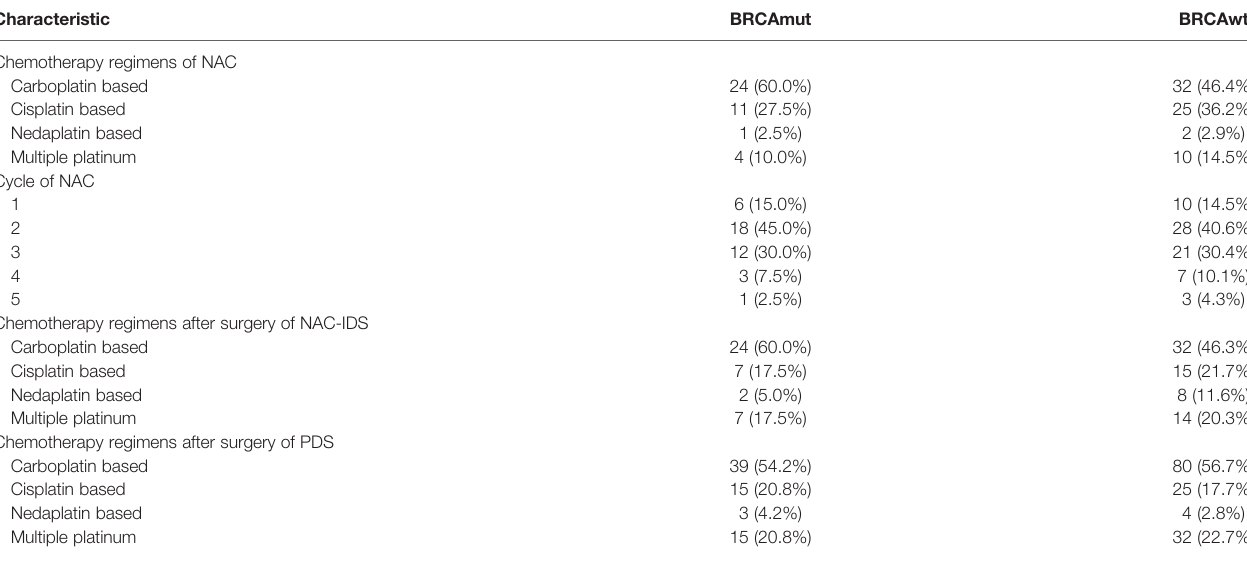
TABLE 1 | Chemotherapy regimens of